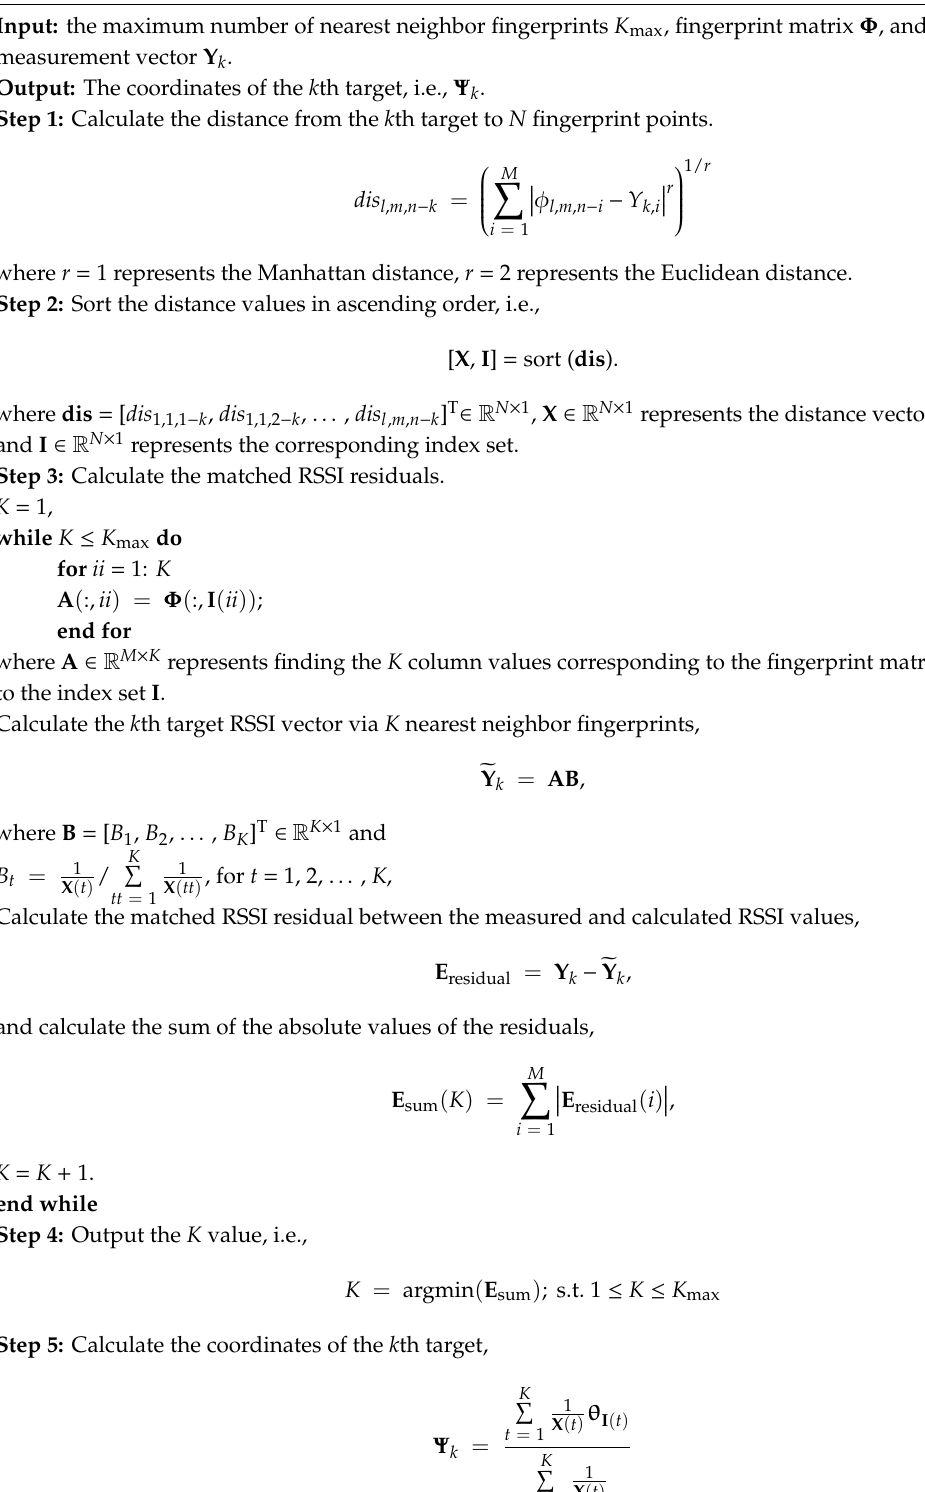
Algorithm 1. ARWKNN